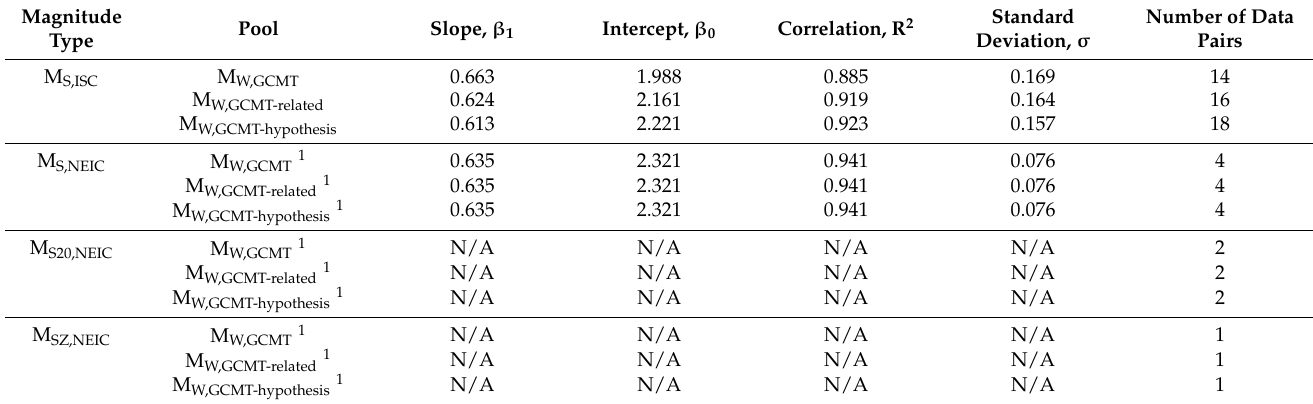
Table 9. Magnitude homogenization regression results from all moment magnitude pools for surface wave magnitude types.